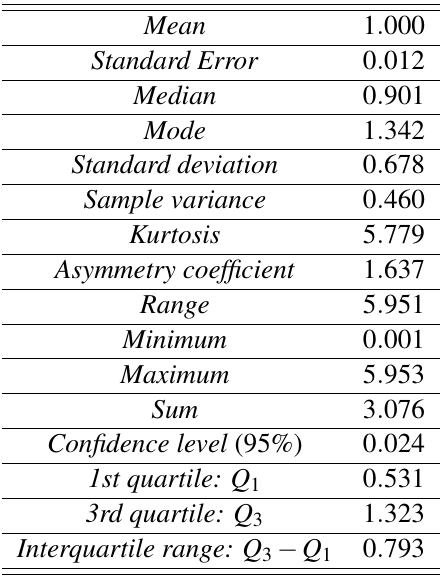
Table 5 Summary statistics for percentage certification data. Source: own elaboration.